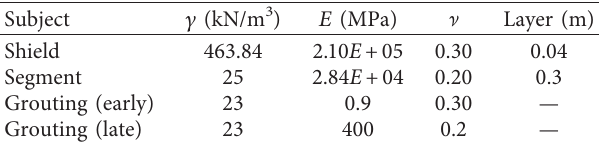
Table 4: Parameters of structures of metro